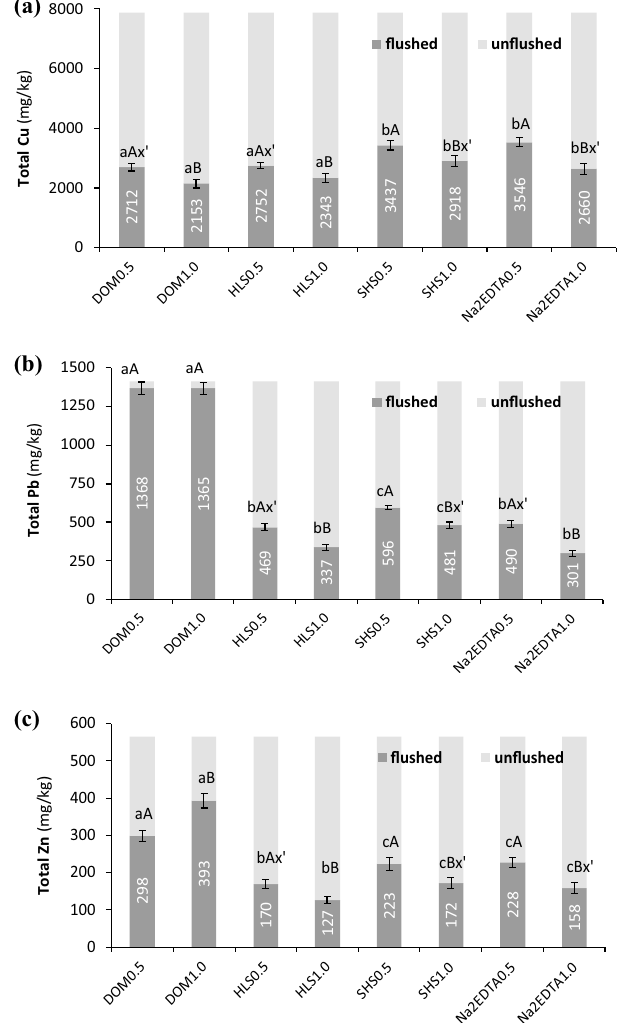
Figure 1. Total HM concentrations in soil before and after flushing with DOM, HLS, SHS and Na 2 EDTA: ( a ) Cu, ( b ) Pb, ( c ) Zn. Small letters (ab) indicate statistically significant differences in HM concentration between the WAs at one flow rate, capital letters (AB) indicate significant differences in HM concentration between the flow rates with one WA. The symbol x’ means no statistically significant differences between treatments. The values in grey columns mean residual HM concentration in flushed